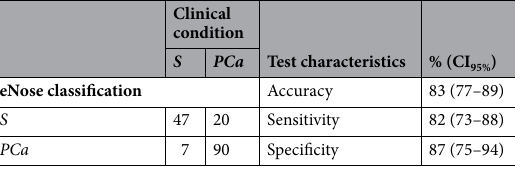
Table 2. Classification results from 10-fold cross validation on urine samples from PCa and control